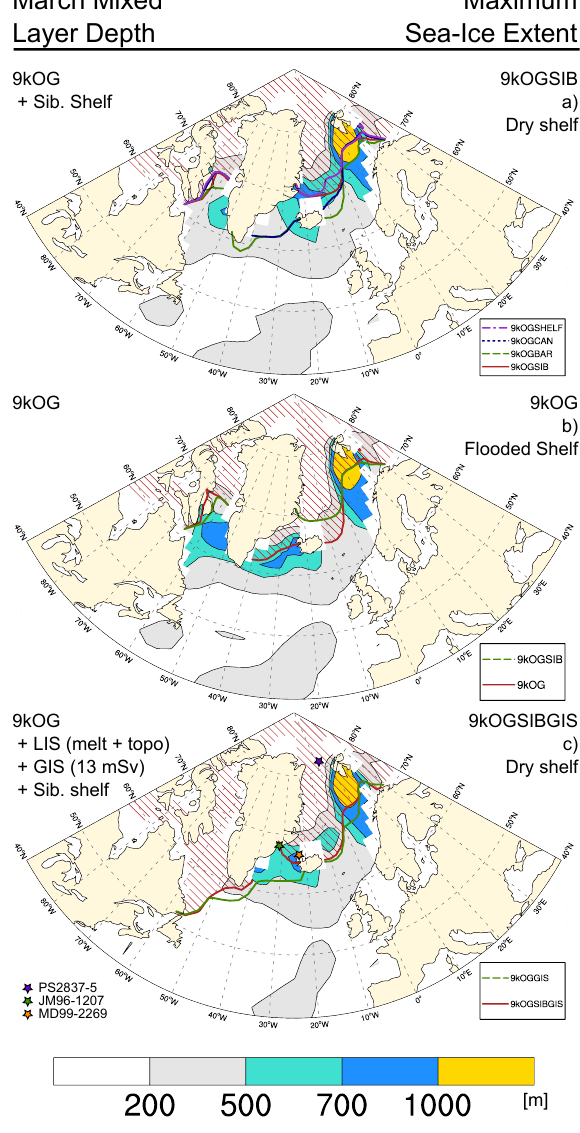
Fig. 4. Maximum winter sea-ice extent and March mixed layer depth for different simulations. (a) Simulation 9kOGSIB, and sea-ice extent contours for additional simulations 9kOGSHELF (purple), 9kOGBAR (green) and 9kOGCAN (blue). (b) simula- tion 9kOG and contours for simulation 9kOGSIB. (c) Simulation 9kOGSIBGIS and sea-ice extent contour for simulation 9kOGGIS (Blaschek and Renssen, 2013). 4221 Fig. 6a) by the shelf flooding in 9kOG as compared to 9kOGSIB is directly related to changes in the land-sea